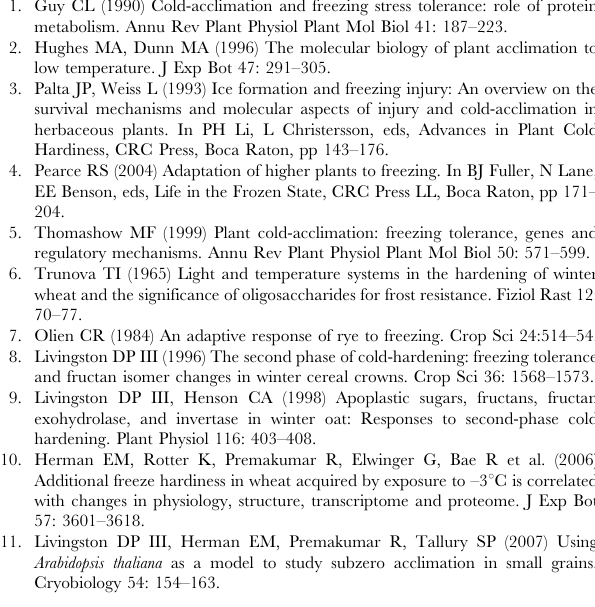
Figure S1 Changes in amino acids and related metabolites in frozen and nonfrozen oat crowns during days 0 to 14 after freezing. (PDF) Figure S2 Changes in sugar related metabolites in frozen and nonfrozen oat crowns during days 0 to 14 after freezing. (PDF) Figure S3 Changes in additional metabolites in frozen and nonfrozen oat crowns during days 0 to 14 after freezing. (PDF) Table S1 Loading values for the first five principal components.